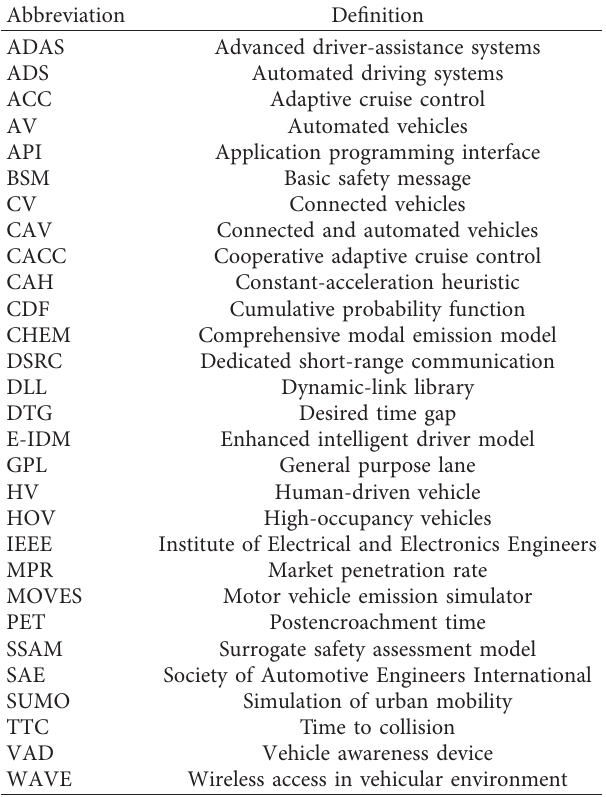
Table 1: List of